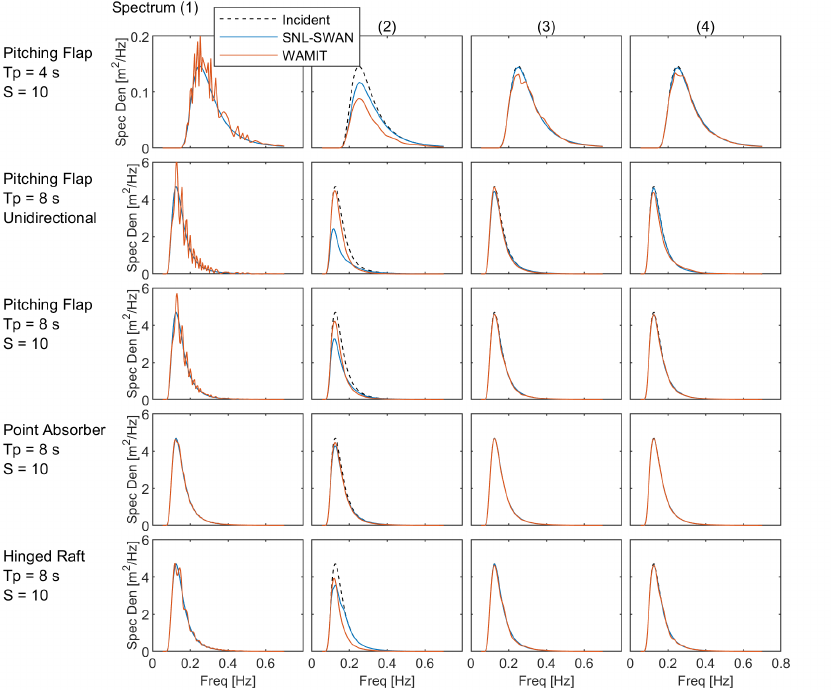
Figure 7. Single WEC Spectra: Plots of the omnidirectional wave spectra at the four points marked in the WAMIT wave field.